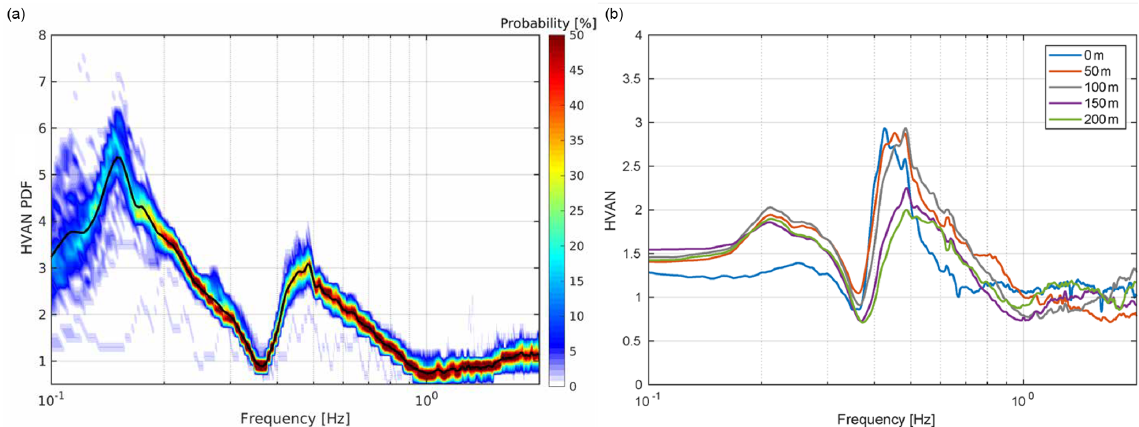
Figure 11. (a) HVAN PDF for 1 month (1 September–1 October 2018) at broadband station G82B, located within 100m of G39, with a depth of 100m. The broadband HVAN PDF displays a peak for the fundamental mode (around 0.15Hz) and the secondary peak (around 0.45Hz) reflects the higher mode for Rayleigh waves or the presence of a second strong impedance contrast. The black line indicates the mean from the HVAN PDF. (b) HVAN curves for 1 month for station G39 for all depth levels.